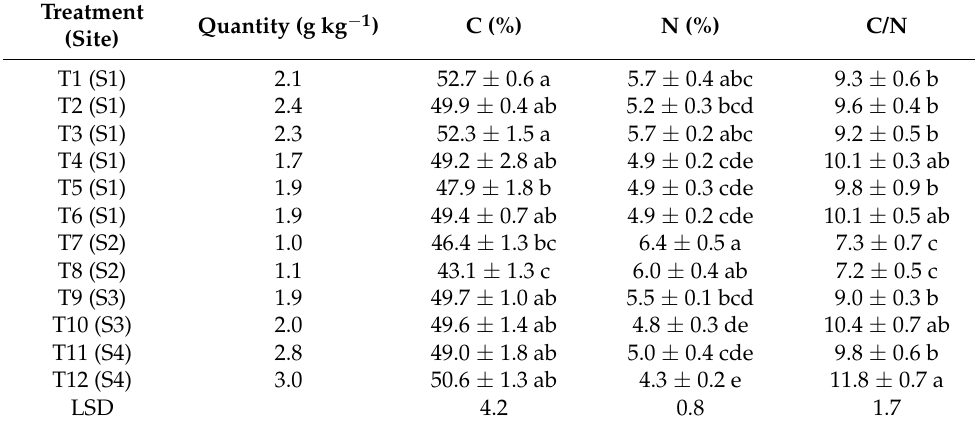
Table 3. Quantity, elemental composition, and C/N ratio of